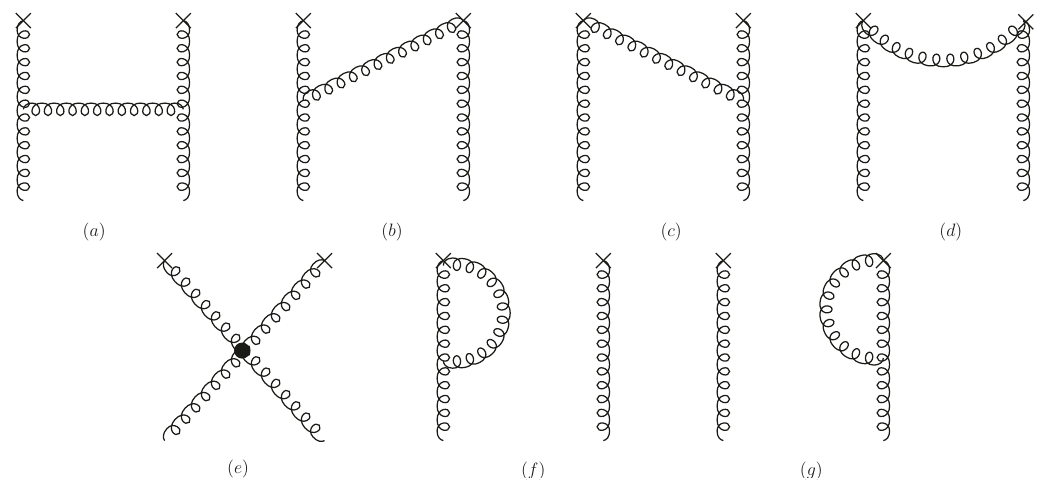
Figure 3 . One-loop corrections to quasi gluon distribution without any Wilson line. The cross “ ” denotes the non-local vertex from the operator structure of ×